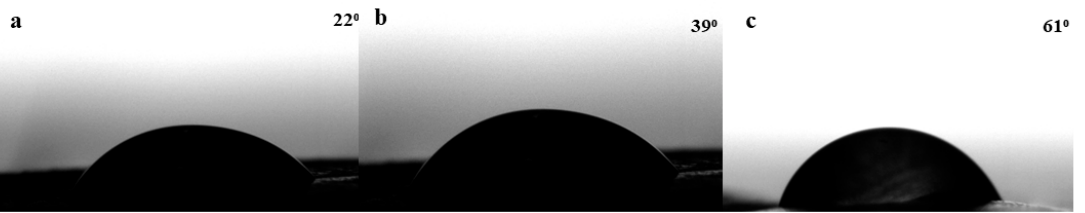
Figure 10. Contact angle measurement of ( a ) cellulose (MCC) control film, ( b ) Cellulose pulp + Cellulose(H)- g -PNIPAAm-Br film at T = 25 ◦ C, ( c ) Cellulose pulp + Cellulose(H)- g -PNIPAAm-Br film at T = 50 ◦ C.